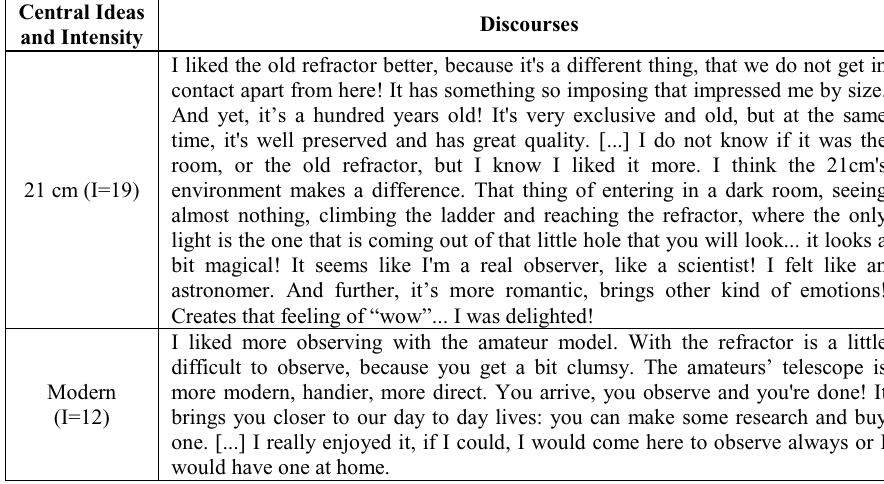
Table 5. Discourses and central ideas obtained when asked “which instrument did you like better? the old 21-cm or the modern amateur